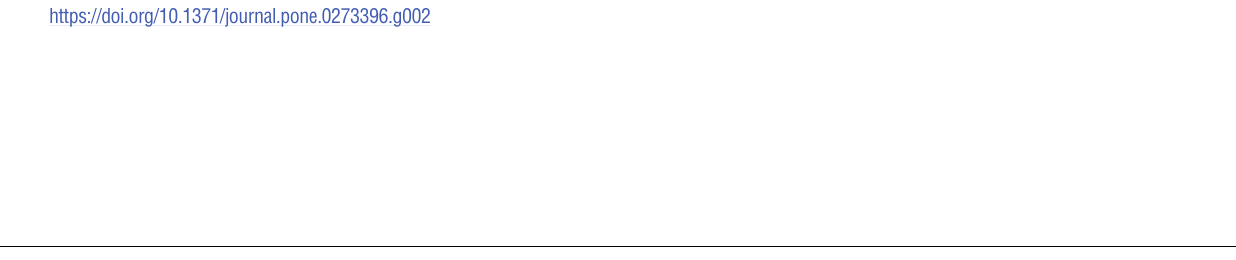
PLOS ONE | https://doi.org/10.1371/journal.pone.0273396 September 12,